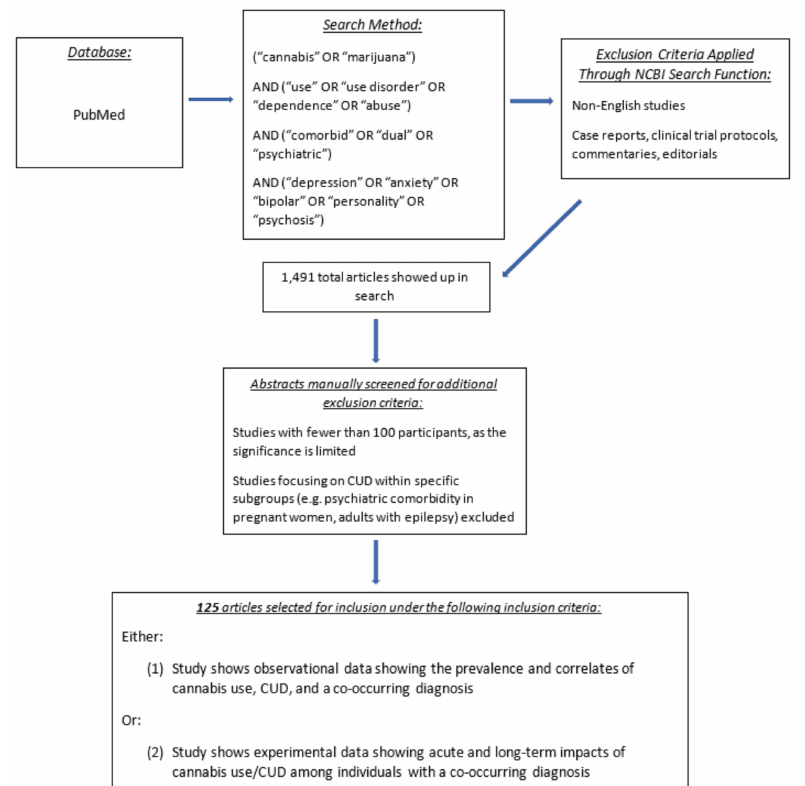
Figure 1. PubMed search strategy to identify studies or meta-analyses with data on cannabis use, cannabis use disorder (CUD), and a co-occurring